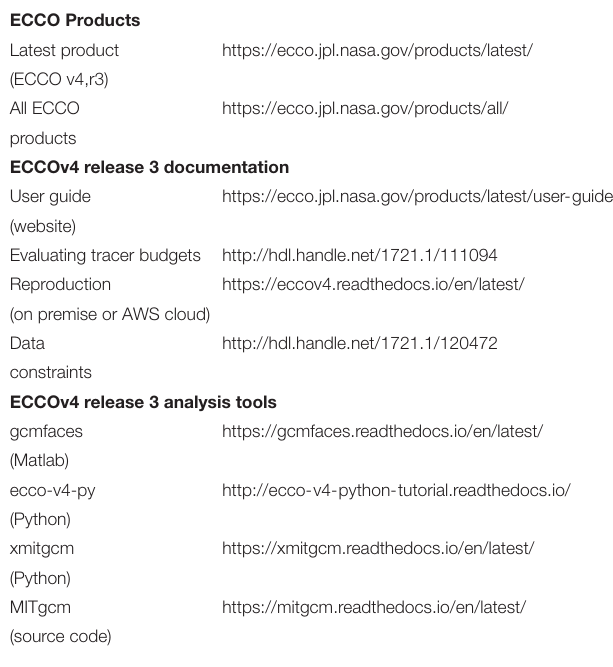
TABLE 1 | Links to ECCO products, configurations, and